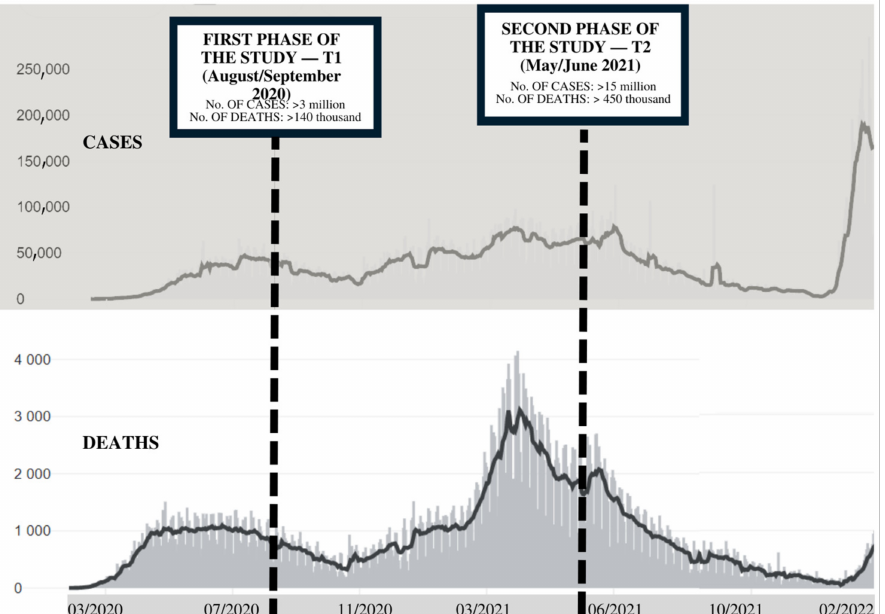
Figure 2. Research phases according to the epidemiological scenario of the COVID-19 pandemic in